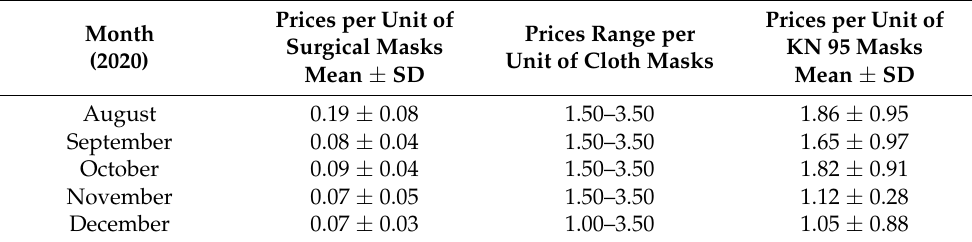
Table 2. Information about prices per unit of cloth, surgical and KN95 non-medical face masks